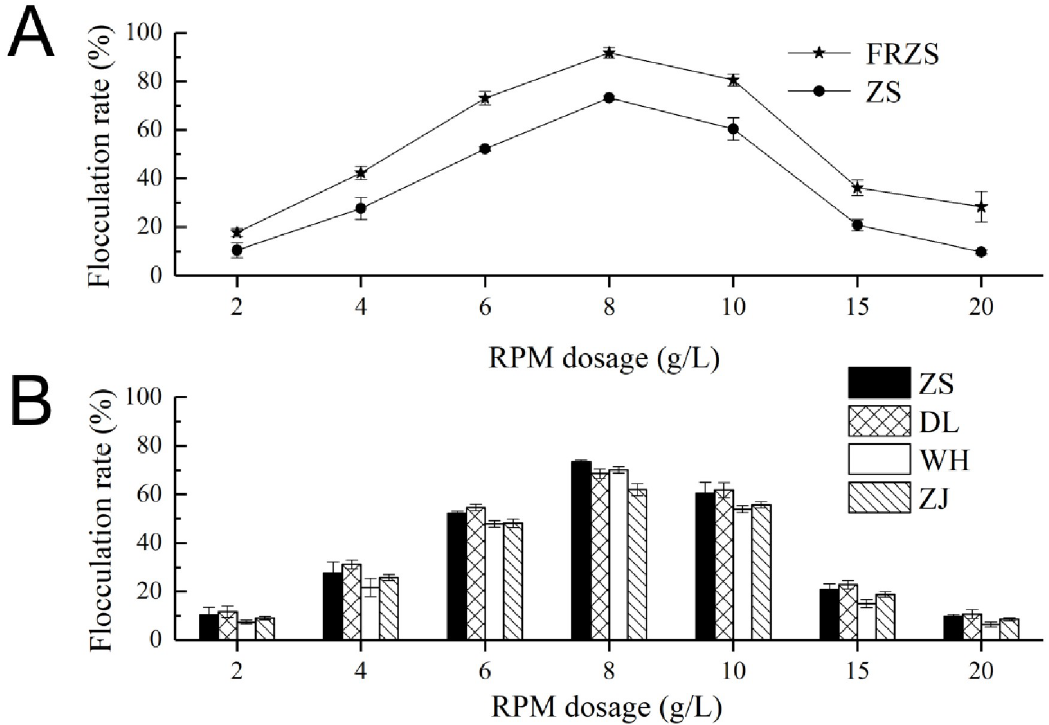
Fig 1. Flocculation activities of the fresh RPM and frozen RPM from Zhoushan (A), and the frozen RPMs from the four coastal locations in China (B). FRZS was fresh RPM from Zhoushan. ZS, DL, WH and ZJ were frozen RPM samples from the Zhoushan, Dalian, Weihai and Zhanjiang locations, respectively. The values are presented as the mean ± SD (n = 3).